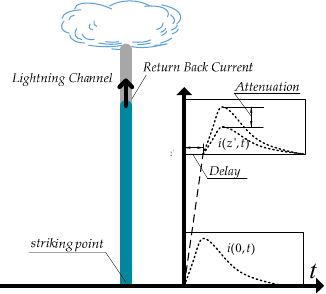
Figure 1. Lightning return stroke